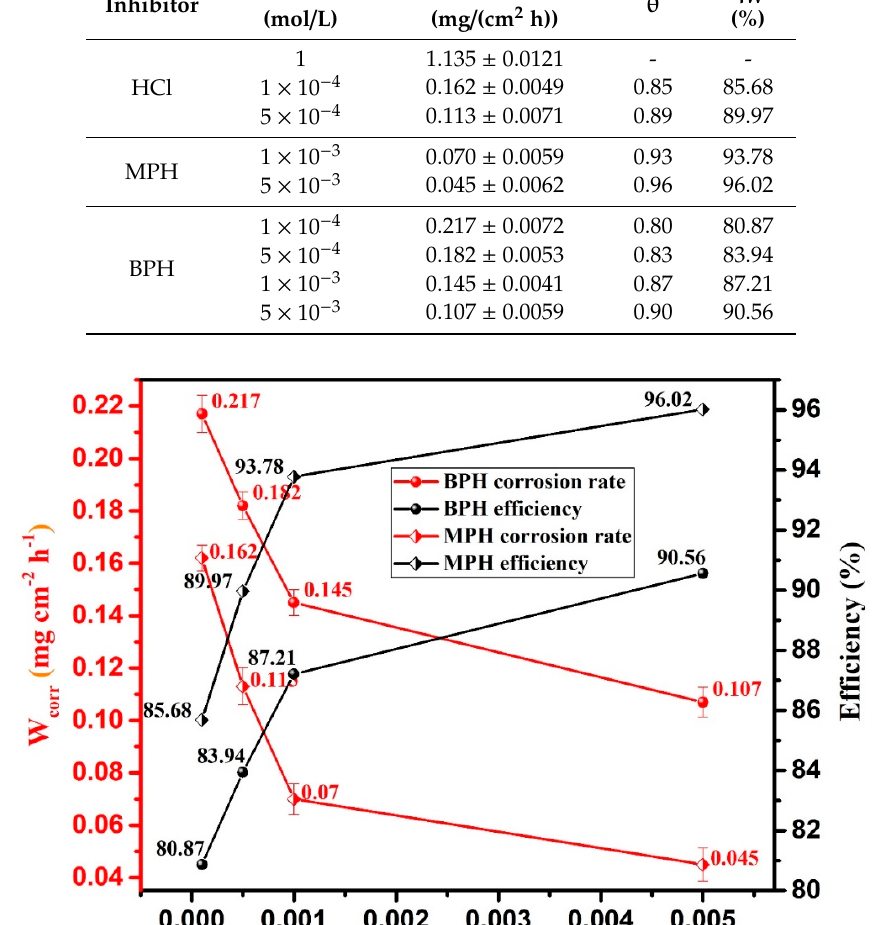
Table 3. The effect of MPH and BPH concentrations on the corrosion data of MS in 1.0 M HCl. Table 3. The e ff ect of MPH and BPH concentrations on the corrosion data of MS in 1.0 M HCl.